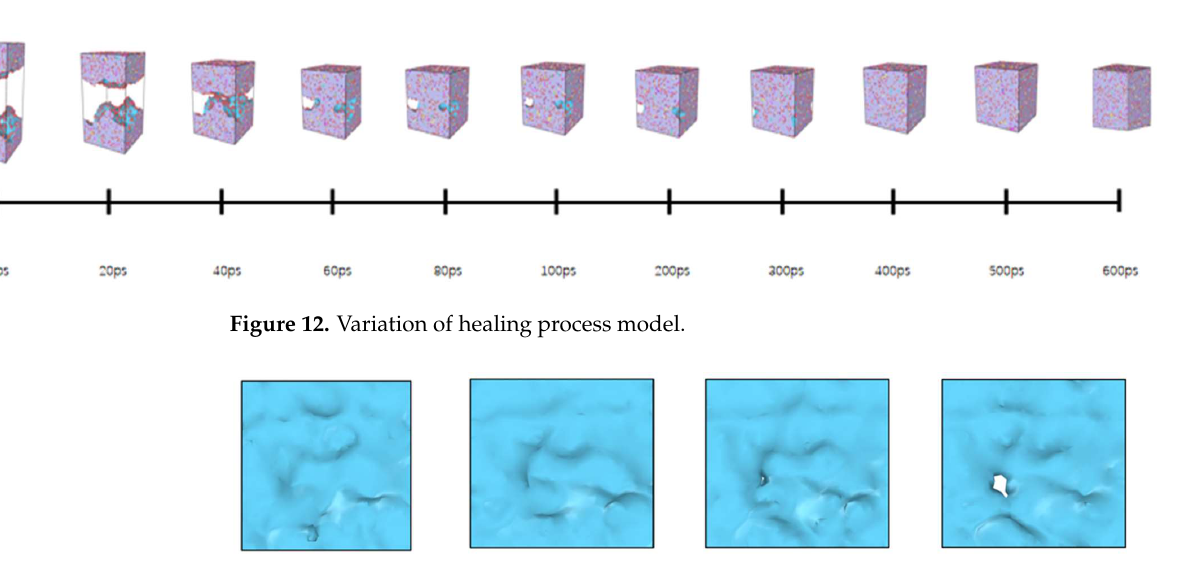
Figure 11. Density and volume change curves during healing process and density distribution curves under different time conditions: ( a ) variation of density and volume with self-healing time; ( b ) density distribution curves under different time conditions.